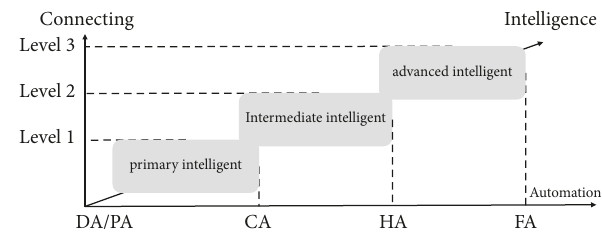
Figure 1: The definition of the intelligent vehicle.